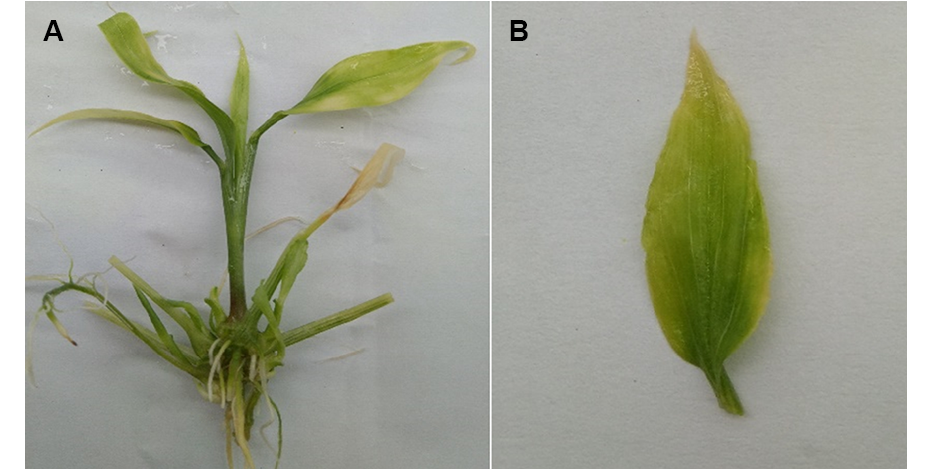
Figure 7 Ginger plantlet ( A ) cultured in MS media with low concentrations of NH 4 NO 3 being 412.5 mg/L and 330 mg/L. The plantlet shows the symptom of nitrogen deficiency with yellow leaves ( B